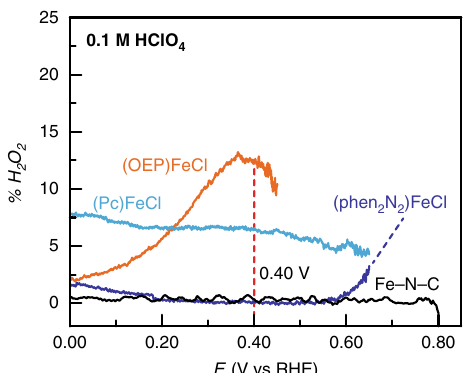
Fig. 8 %H 2 O 2 vs potential for adsorbed catalysts. All data were recorded in O 2 -saturated 0.1 M HClO 4 electrolyte at 5 mV s − 1 and 2000 rpm rotation rate. (phen 2 N 2 )FeCl is shown in blue, (OEP)FeCl is shown in orange, (Pc)FeCl is shown in aqua, and Fe-N-C is shown in